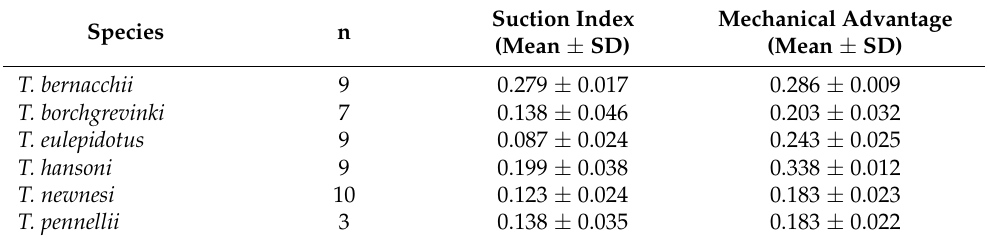
Table 2. Calculated values of suction index (SI) and mechanical advantage (MA) in the six species. Suction Index Mechanical Advantage Species n (Mean ± SD) (Mean ± SD) T. bernacchii 9 0.279 ± 0.017 0.286 ± 0.009 7 0.138 ± 0.046 0.203 ±